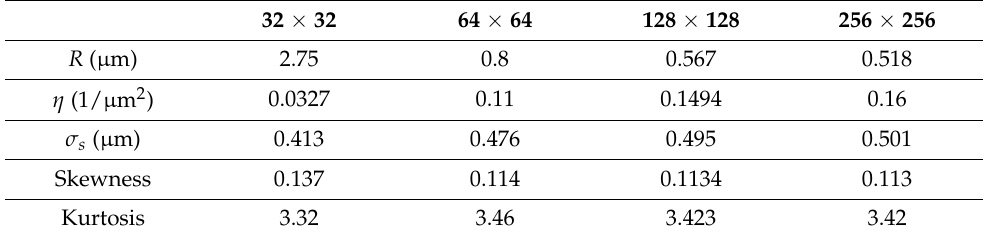
Table 2. Statistical parameters of surface 63M.